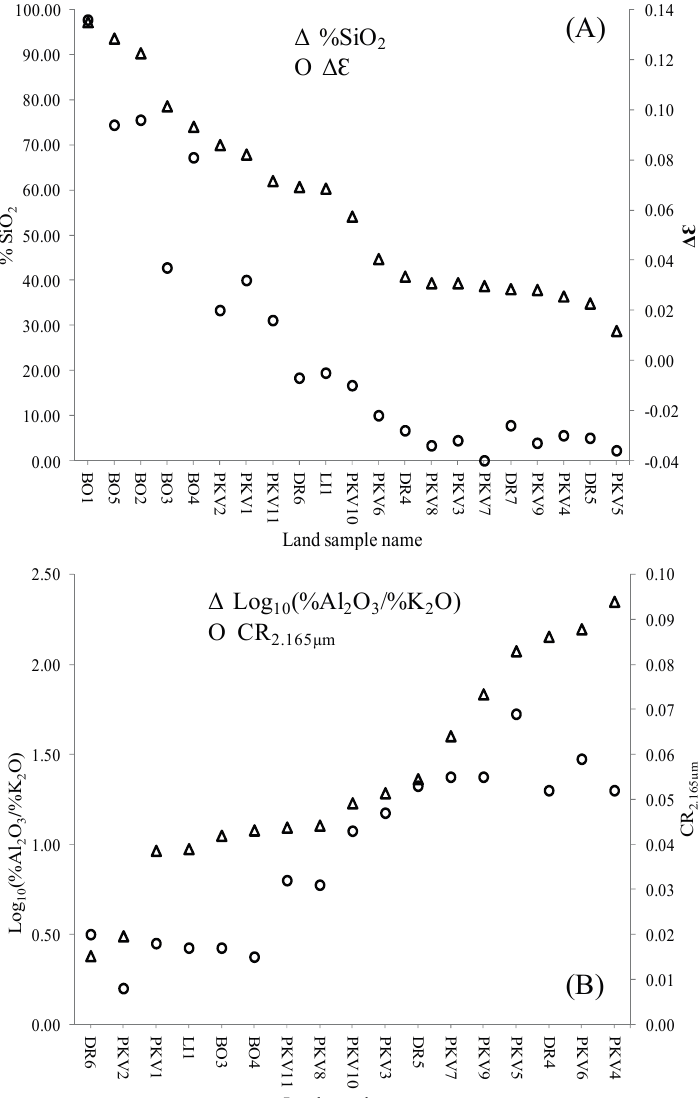
values (primary y-axis) and calculated ΔԐ 2 values (secondary y-axis) 2.165µm